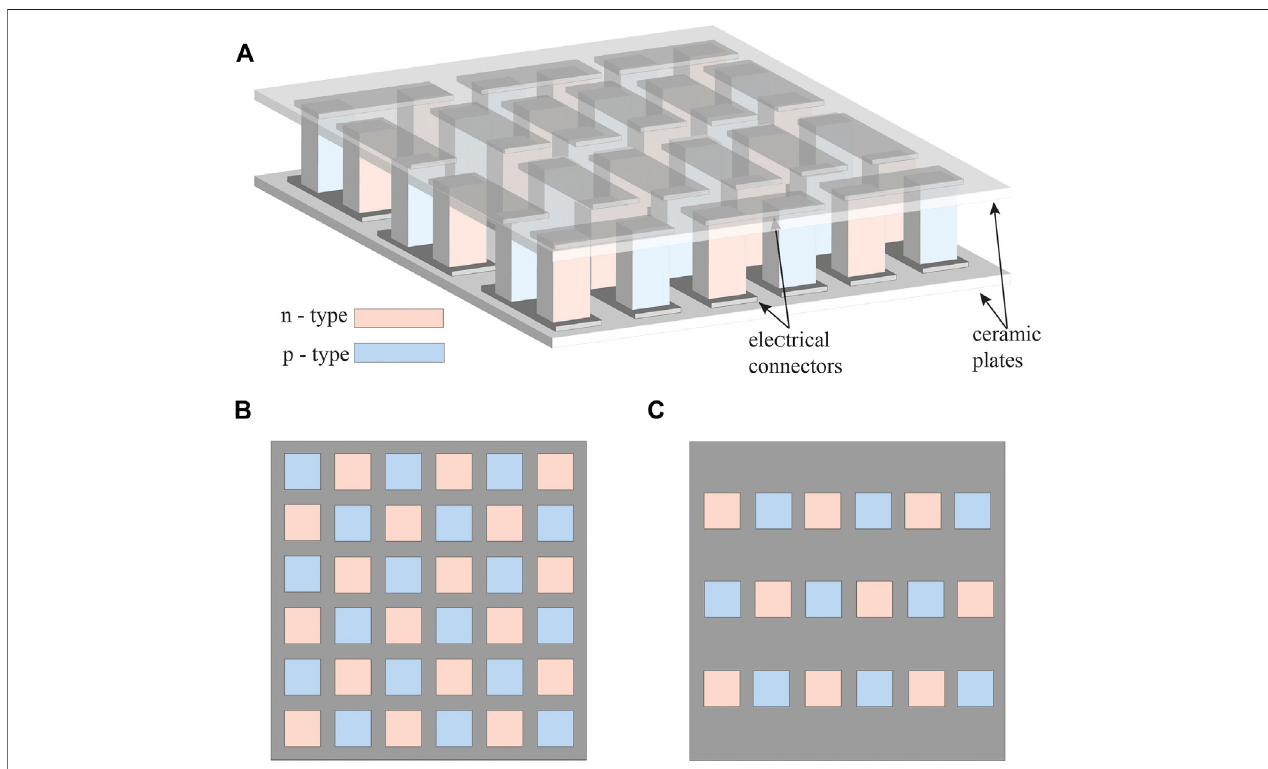
FIGURE 1 | (A) Schematic of a thermoelectric module with multiple n - and p -type leg couples. (B) Top view of the module. (C) Representation showing a fi ll factor that is 50% of the one in (B) .